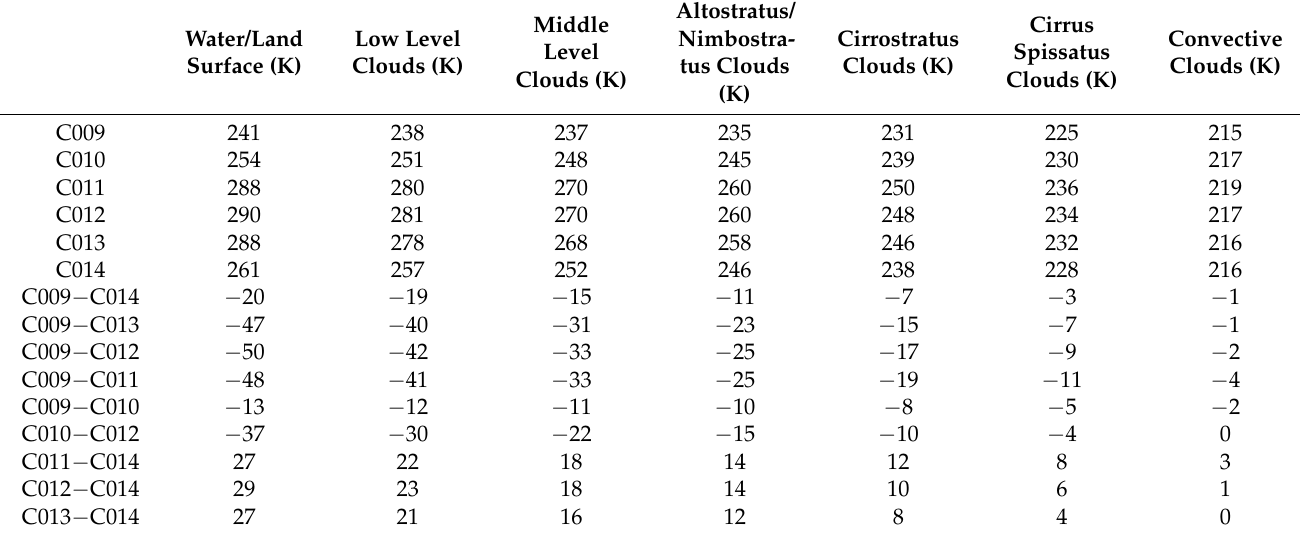
Table 3. The used channel TB and TB difference thresholds for cloud classification based on the FY-4A AGRI.